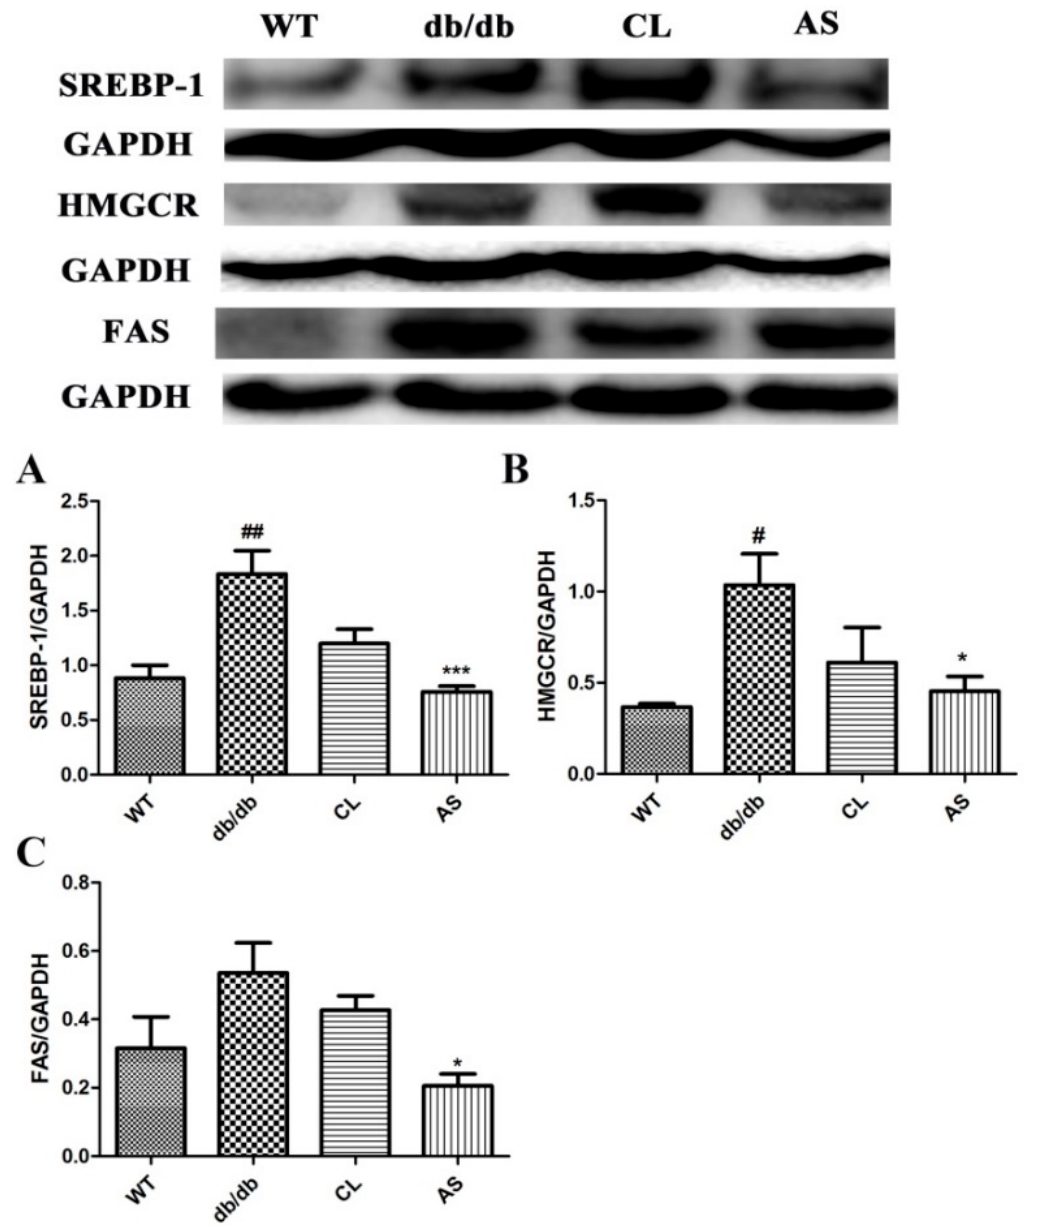
Figure 6. AS inhibited the lipid synthesis-related protein expressions in liver. ( A ) SREBP-1 and ( B ) HMGCR; ( C ) FAS protein expression in liver was analyzed by Western blot. Immunoblots are representative of five independent experiments; GAPDH served as a loading control. Values are expressed as mean ± SEM of five mice. * p < 0.05, *** p < 0.001 vs. db/db group; # p < 0.05, ## p < 0.01 vs. WT group.